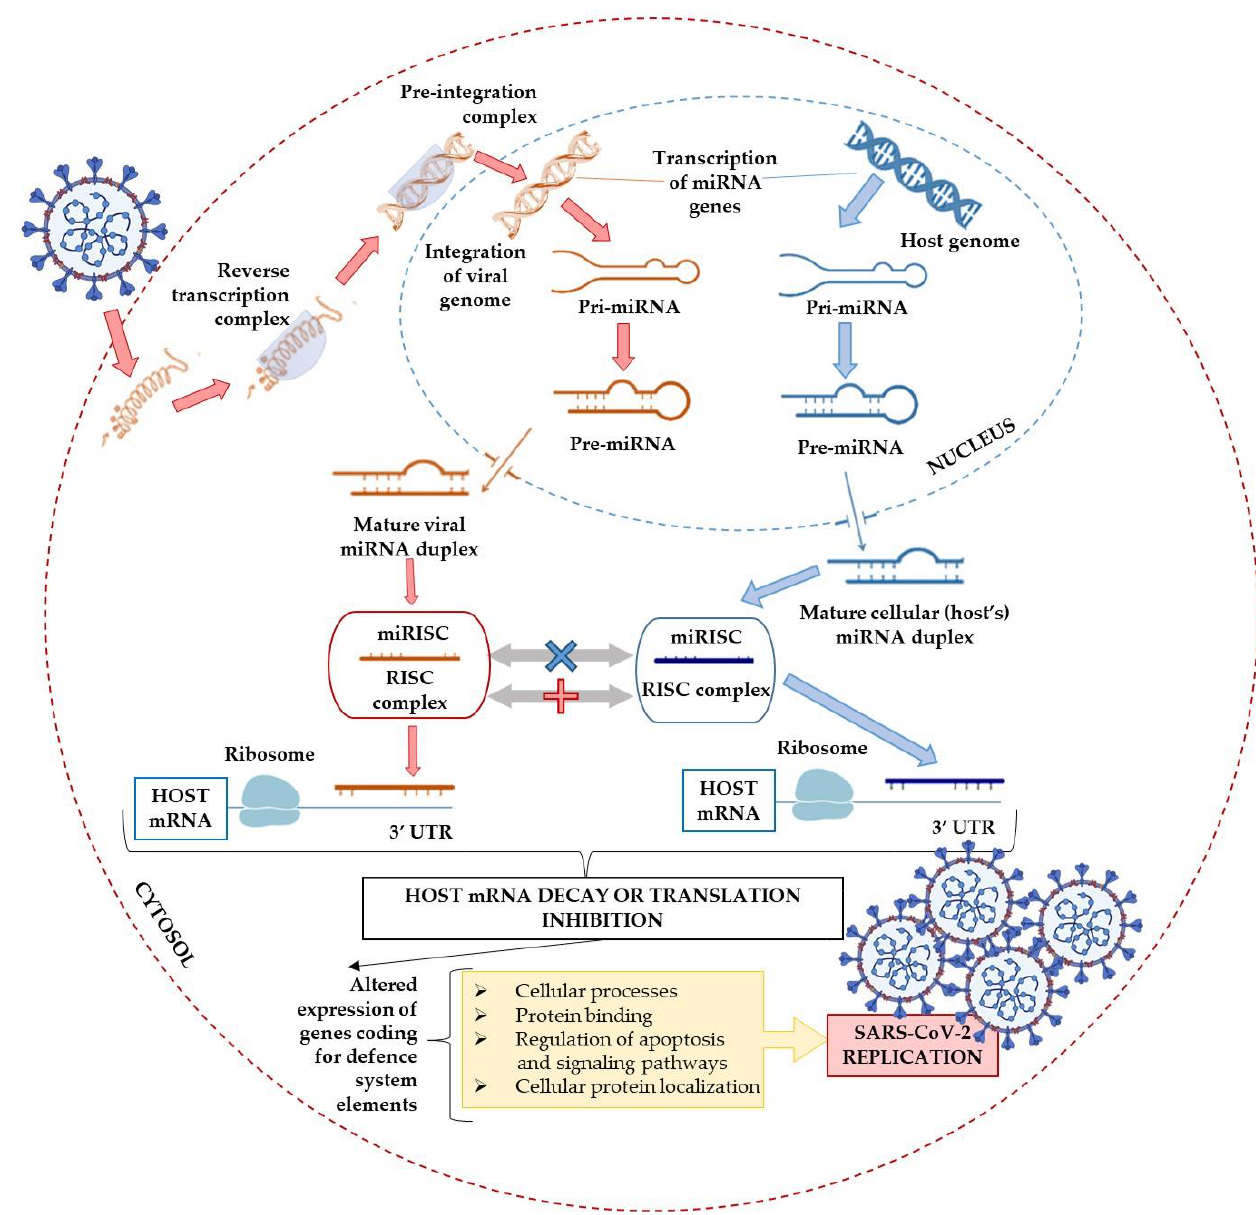
Figure 4. Possible mechanism of viral genome integration into the host’s cell and contribution of the SARS-CoV-2 miRNAs to the infection efficacy.